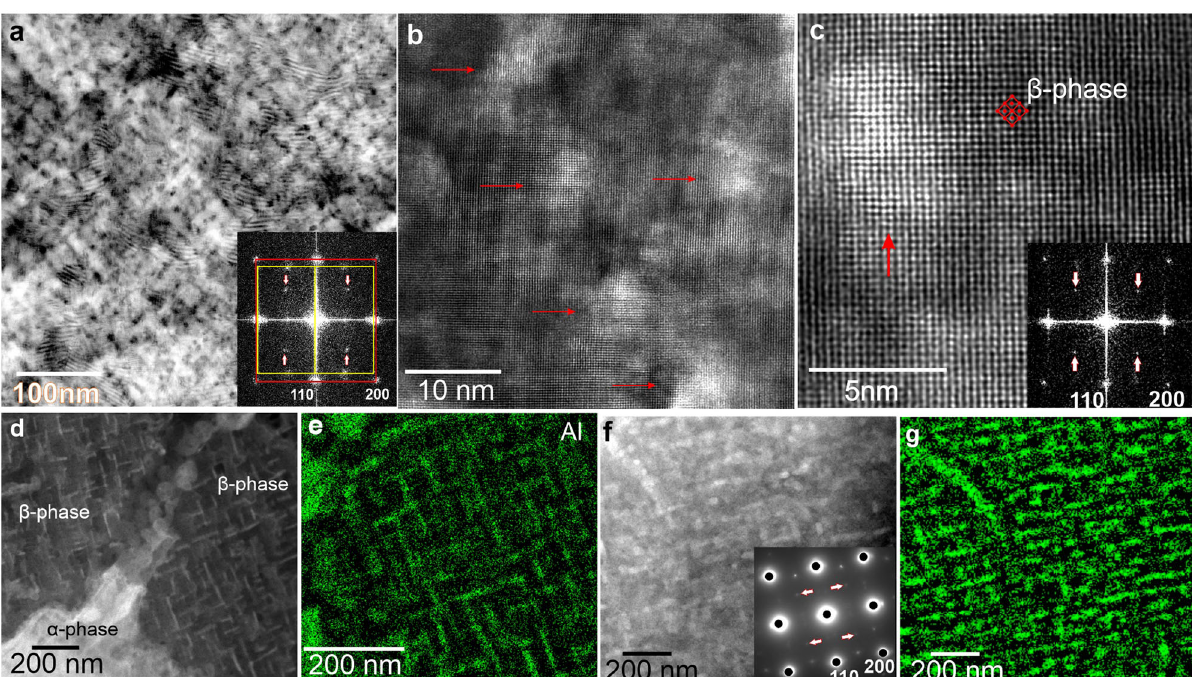
Fig. 5 TEM characterisation of the evolution of intermetallic phases in FSP sample during natural ageing. a BF-STEM showing dense nano-precipitates and ( b , c ) atomic-scale HAADF-STEM showing the structure of nano-precipitates in the β -phase matrix, as indicated by red arrows. d – g HAADF-STEM images and corresponding EDS-STEM Al mapping of FSP sample after natural ageing for ( d , e ) 3 months and ( f , g ) 2 years. Yellow and red frames in the inset FFT pattern in ( a ) indicated the diffractions from the α and β phase, and arrows in inset FFT in ( a , c ) and diffraction pattern in ( f ) indicated the diffraction from the θ phase. The incident beam was parallel to [001] β